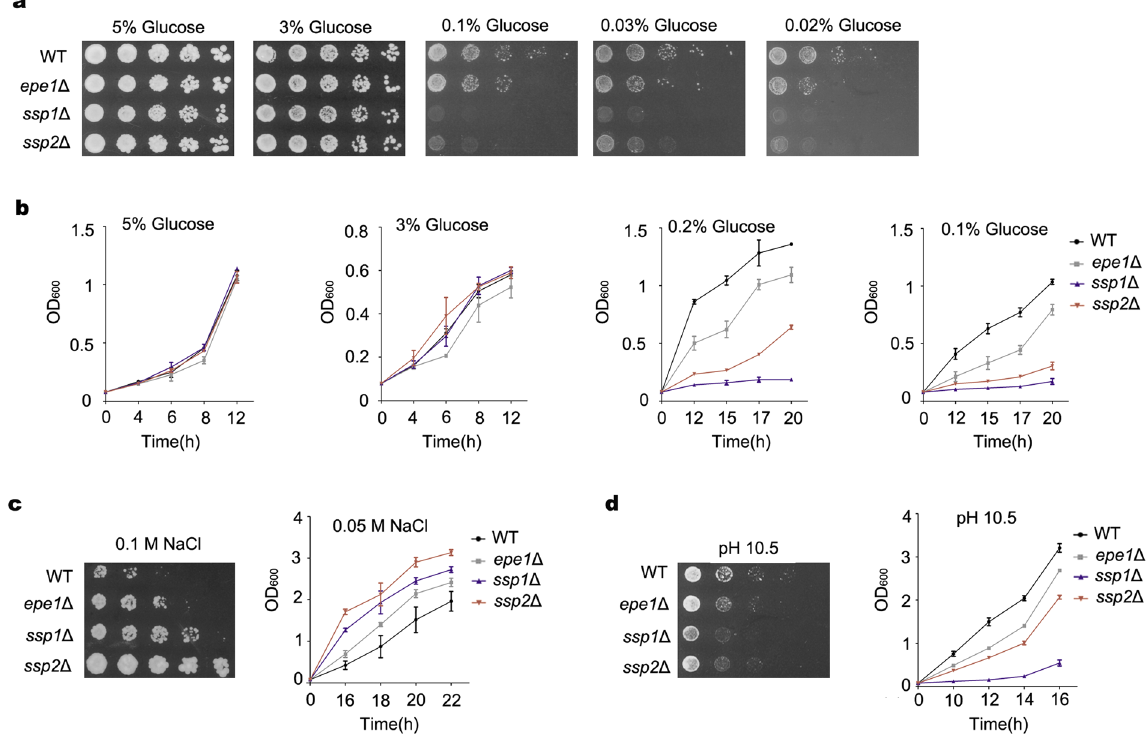
Figure 1. Deletion of epe1 + impairs adaptive responses to environmental stresses. ( a ) Growth of WT, epe1 Δ , ssp1 Δ and ssp2 Δ cells on low-glucose solid medium in serial dilution assays. ( b ) Growth of WT cells and mutants in low-glucose liquid medium. Values in ( b ) and below represent mean ± s.d. from three parallel cultures. ( c ) Growth of WT cells and mutants on medium containing 0.1 M NaCl or in liquid medium containing 0.05 M NaCl. ( d ) Growth of WT cells and mutants at pH